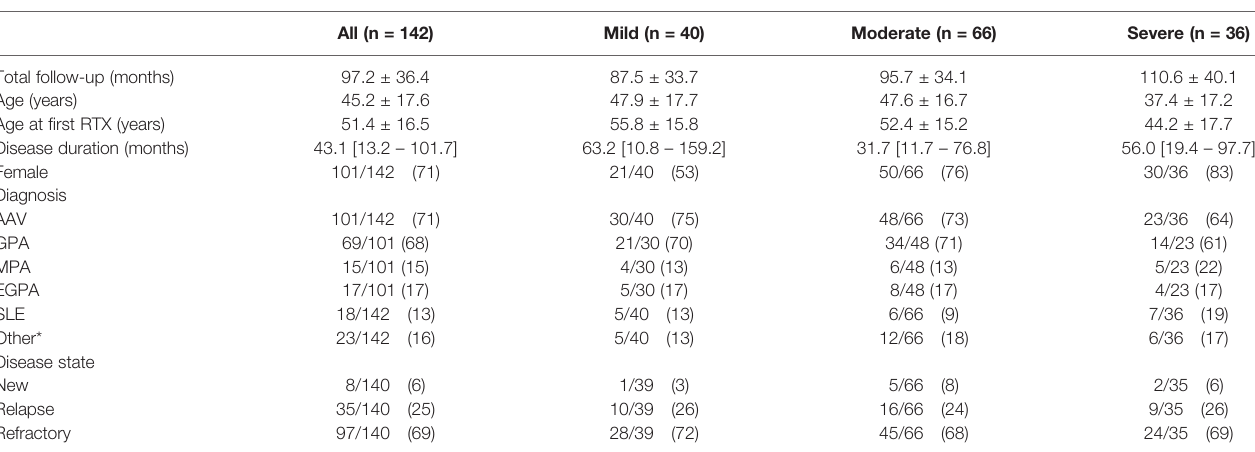
TABLE 1 | Patient